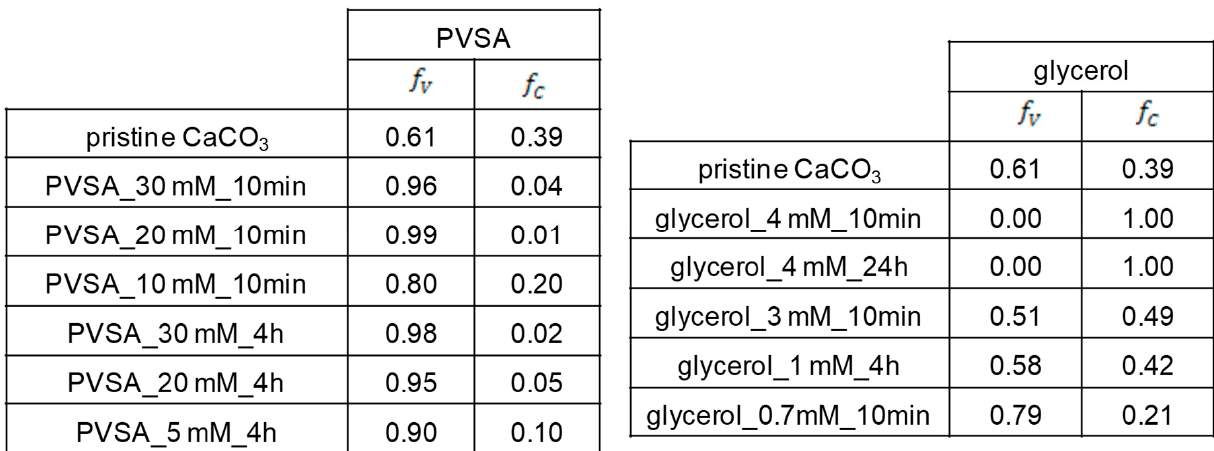
Figure 4. XRD patterns of ( A ) CD-CaCO 3 particle, ( B ) CD-CaCO 3 particle with PVSA and ( C ) CD-CaCO 3 particle with glycerol. ( B ) (a) CD-CaCO3 microparticle, (b) CD-PVSA_30 mM_10min,